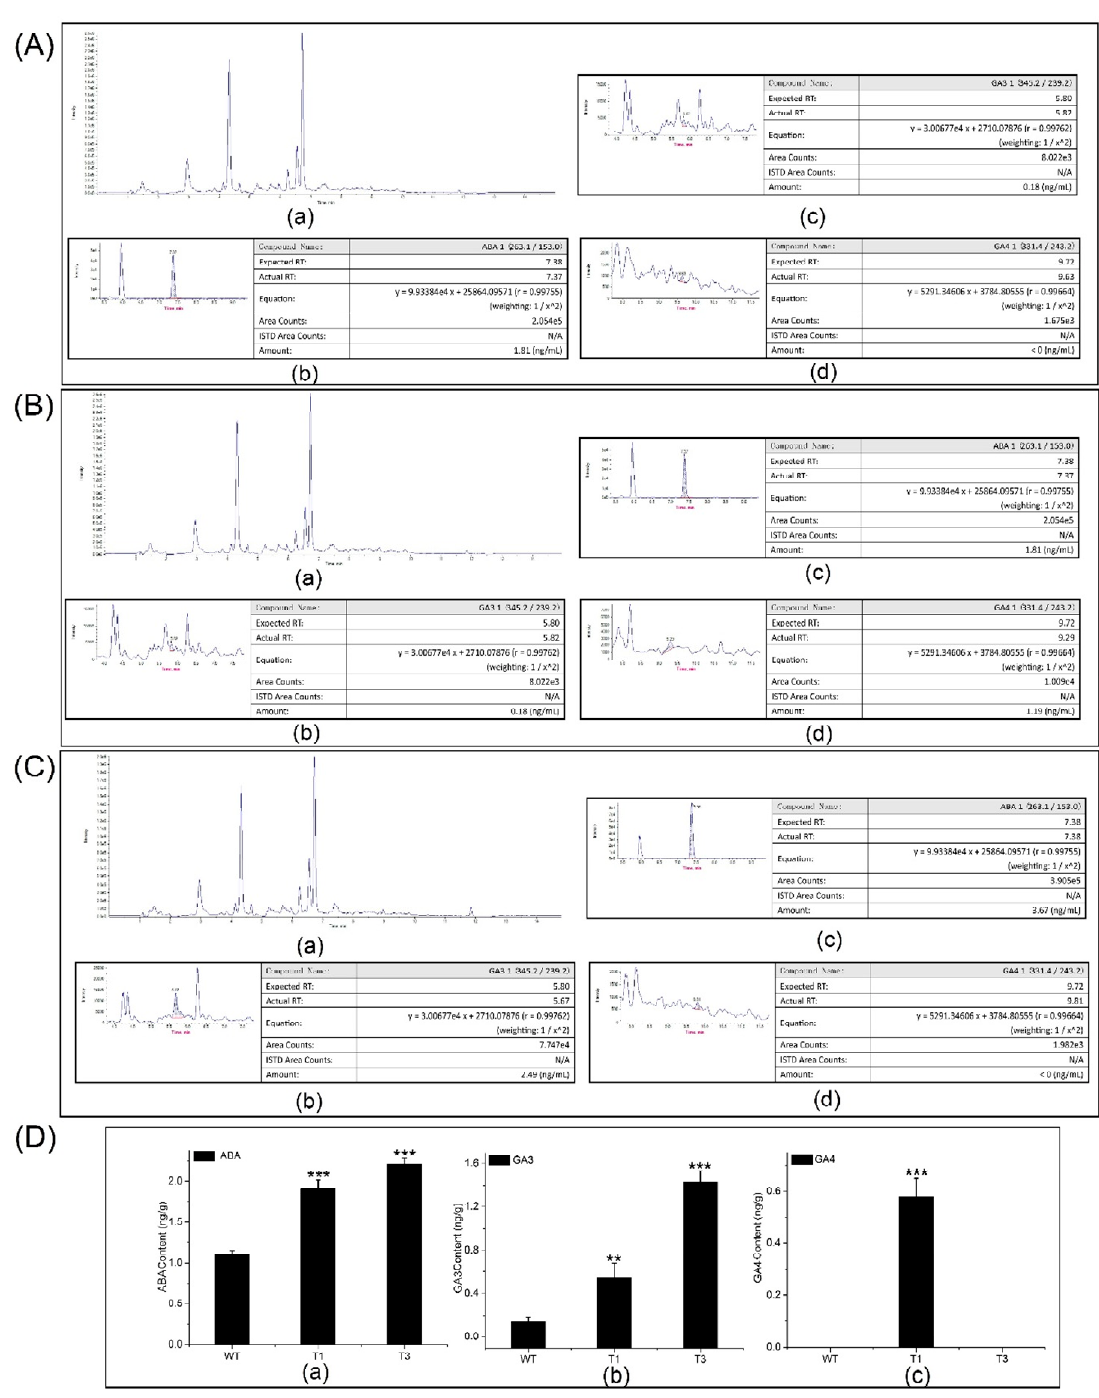
Figure 6. ABA, GA3, and GA4 contents in the transgenic and WT plants by HPLC-MS/MS. ( A ) Raw data and ABA, GA3, and GA4 contents of WT plants. ( B ) Raw data and ABA, GA3, and GA4 contents of T1 plants. ( C ) Raw data and ABA, GA3, and GA4 contents of T3 plants. ( D ) Comparison of the ABA, GA3, and GA4 contents of transgenic and WT plants. Asterisks represent significant differences relative to WT poplars (Student’s t -test; **, and ***, p < 0.01, and p < 0.001, respectively).